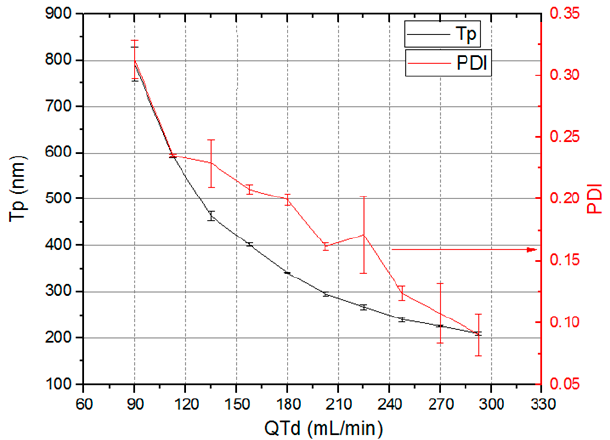
Figure 21. Nanocapsules sizes Tp and polydispersity index (PDI) versus total flow rate through devices.